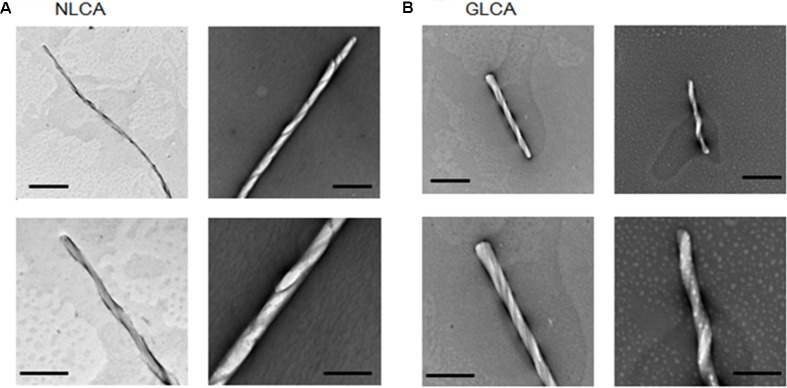
Tubular structures of in vitro assembled NL4-3 and GL-AN CA proteins. CA proteins were fully polymerized in vitro, fixed by glutaraldehyde, and visualized via TEM as previously described (Sakaguchi et al., 2002; Piroozmand et al., 2006). (A,B) represent micrographs of HIV-1 NL4-3 CA (NLCA) and HIV-2 GL-AN CA (GLCA), respectively. Scale bars: 1 μm in upper panels; 200 nm in lower panels.